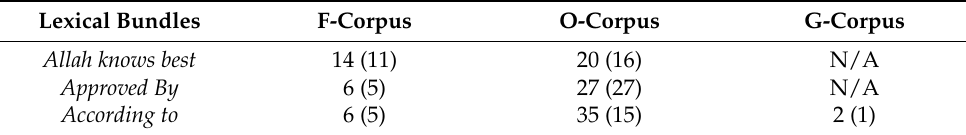
Table 3. Frequency of frequent lexical bundles in the FOG corpus along with range. Lexical Bundles